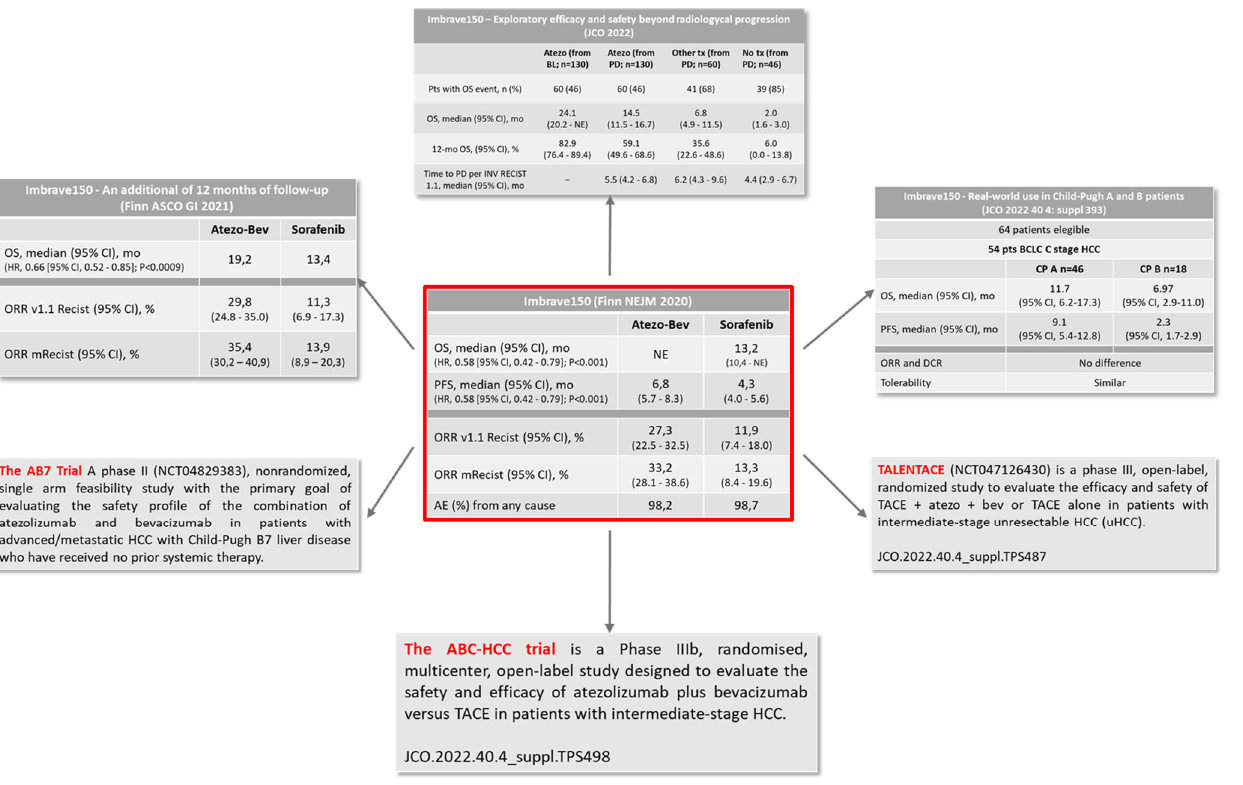
Figure 3. The IMbrave150 trial and further